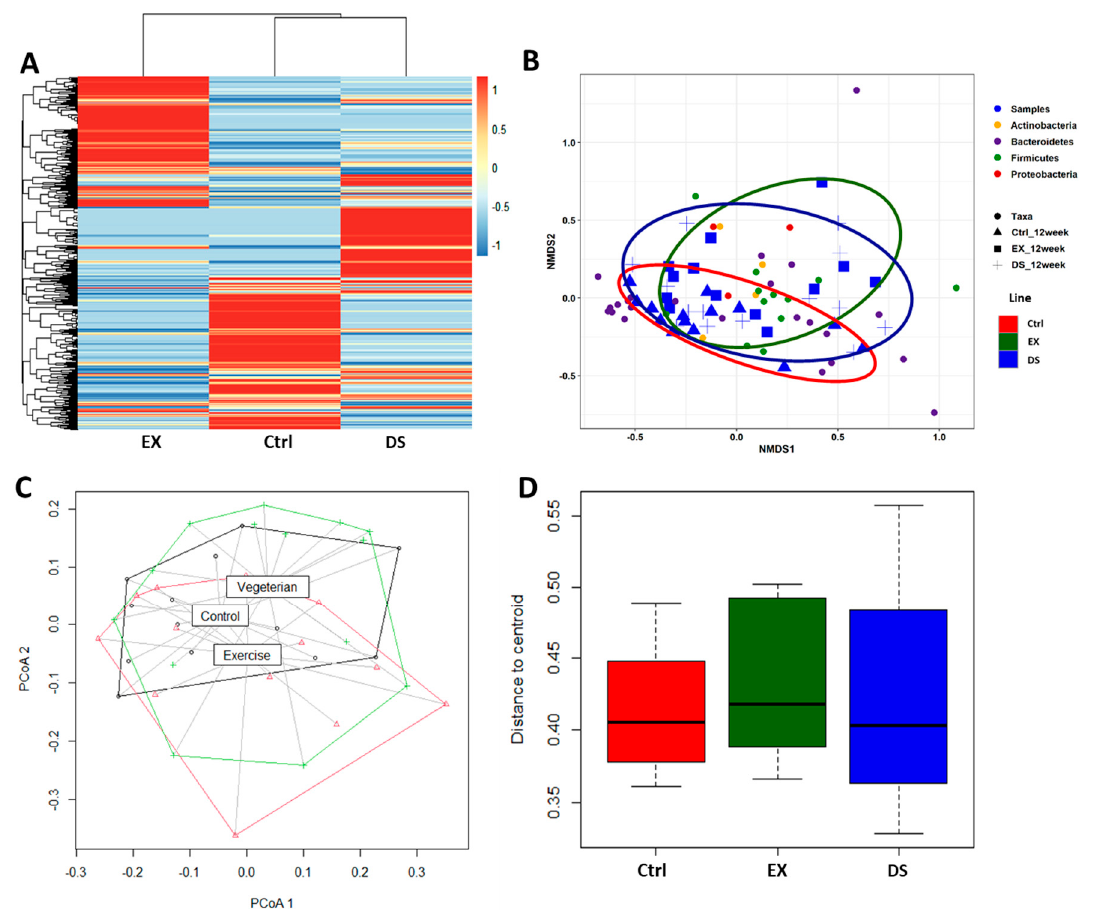
Figure 2. β − Diversity comparison of the gut microbiome of the Ctrl, EX, and DS groups. ( A ) Heatmap of the microbial composition for the Ctrl, EX, and DS groups based on the Bray–Curtis distance matrix calculated from normalized OTU values at the species level. ( B ) Nonmetric multidimensional scaling (NMDS) plots showing the difference in the gut microbiome in the Ctrl, EX, and DS groups based on Bray–Curtis distances by using OTUs. ( C ) Principal coordinate analysis (PCoA) based on the unweighted UniFrac metric of the gut microbiome in the Ctrl, EX, and DS groups. ( D ) Distance of centroid for the Ctrl, EX, and DS groups. The Ctrl, EX, and DS represent the control, exercise, and diet shift groups, respectively.